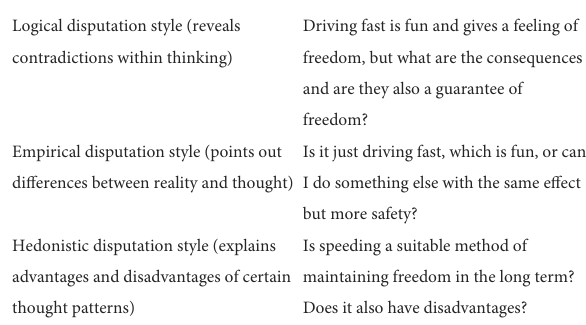
TABLE 1 Overview of disputation techniques from cognitive behavioral therapy according to Wills,